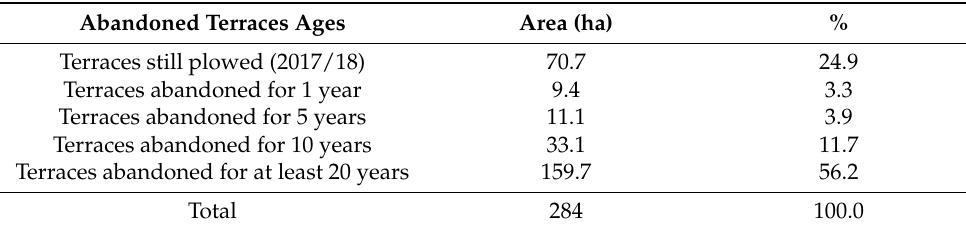
Figure 2. Mapping of the age of abandonment of the terraces in the villages of Tizerkine and Timzemzit, Ait Baha, Western Anti-Atlas, Morocco. Table 3. Evolution of the areas of abandoned terraces in the territory of Tizerkine and Timzemzit, Ait Baha, Western Anti-Atlas,